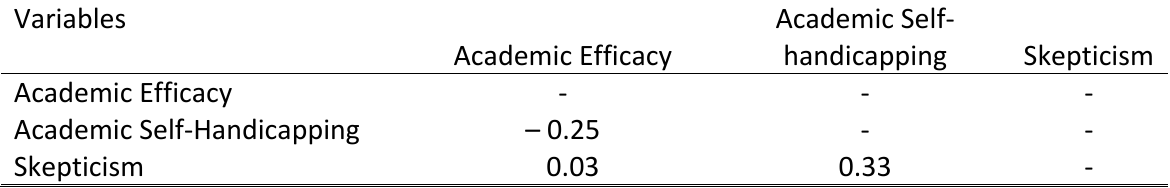
Correlations for Academic Efficacy, Academic Self-Handicapping, and Skepticism